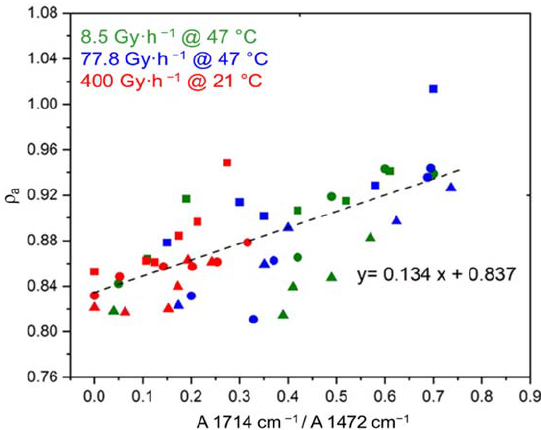
Figure 9. Density of the amorphous phase versus carboxylic acid index for the Si ‐ XLPE matrix filled with 0 phr ( □ ), 25 phr ( ), and 50 phr ( ) of ATH, during its radio ‐ thermal exposure in air under 8.5 Gy · h − 1 at 47 ◦ C (green), under 77.8 Gy · h − 1 at 47 ◦ C (blue), and under 400 Gy · h − 1 at 21 ◦ C (red).